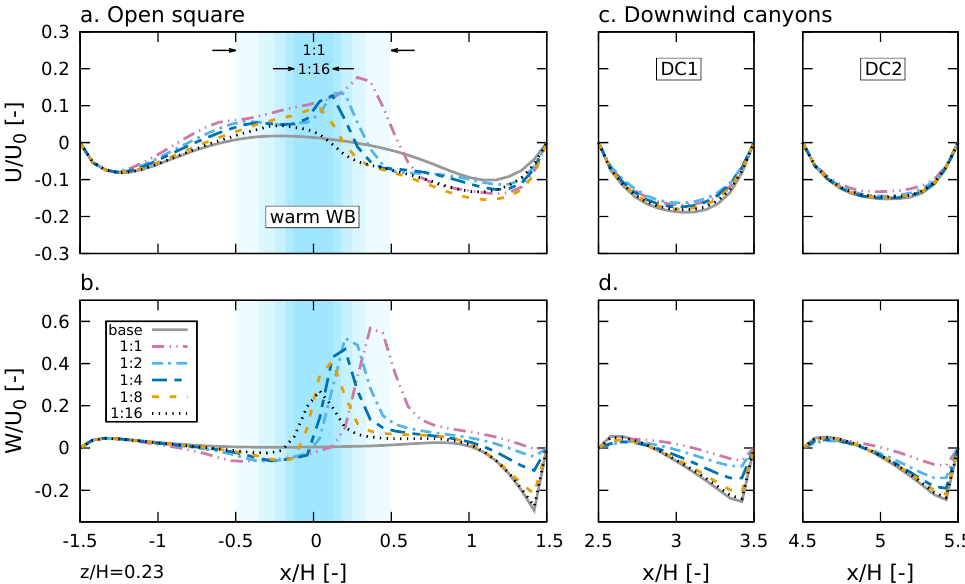
Figure 7. Profiles of normalised velocity ratios over a horizontal line across the middle of the domain ( y / H = 0) at pedestrian level ( z / H = 0.23) for the warm water body cases ( ∆ T = + 2 K) and for different water body sizes: ( a , b ) results within the open square ( − 1.5 ≤ x / H ≤ 1.5) for streamwise ( U / U 0 ) and vertical velocity ( W / U 0 ), respectively; ( c , d ) results within the downwind canyons